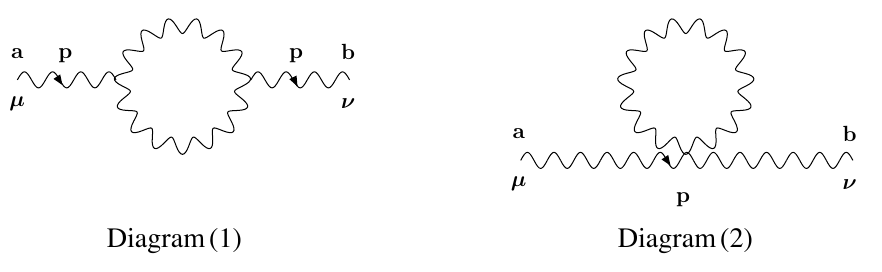
Figure 3 . Gluonic one-loop Feynman diagrams contributing to the 2-point functions of higher derivative